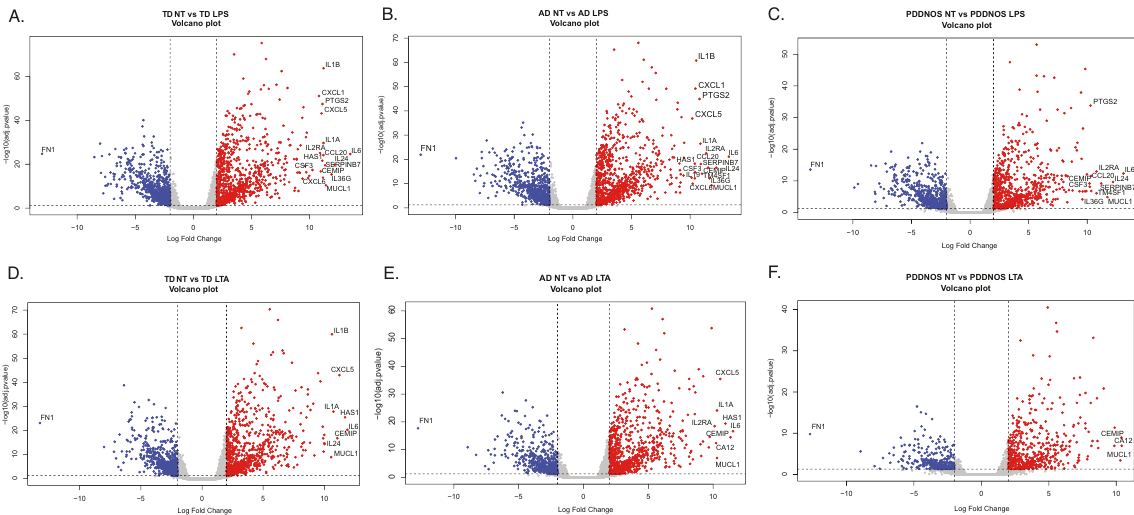
Fig. 1 Differentially expressed genes in response to LPS or LTA stimulations. A Volcano plot of DEGs for TD NT compared to TD LPS. B Volcano plot of DEGs for AD NT compared to AD LPS. C Volcano plot of DEGs for PDDNOS NT compared to PDDNOS LPS. D Volcano plot of DEGs for TD NT compared to TD LTA. E Volcano plot of DEGs for AD NT compared to AD LTA. F Volcano plot of DEGs for PDDNOS NT compared to PDDNOS LTA. For A-F genes in red are signi fi cantly upregulated with a Log2 Fold Change greater than 2 and genes in blue are signi fi cantly downregulated with a Log2 Fold Change less than 2. Genes with a Log2 Fold Change greater or less than 10 are labeled. AD: autistic disorder, TD: typical developing controls, PDD/NOS: pervasive development disorder not otherwise speci fi ed, NT: no treatment, LPS: lipopolysaccharide, LTA: lipoteichoic acid.